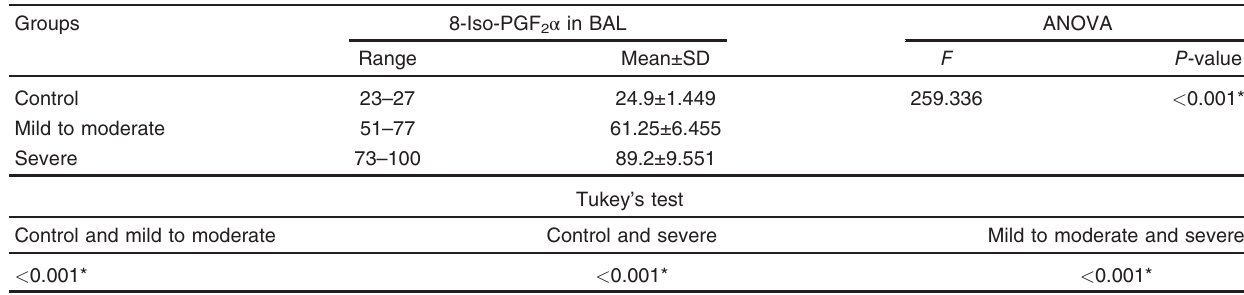
Table 3 Statistical comparison of range, mean±SD values of bronchoalveolar lavage fluid levels of 8-isoprostane (ng/ml) in the three studied groups